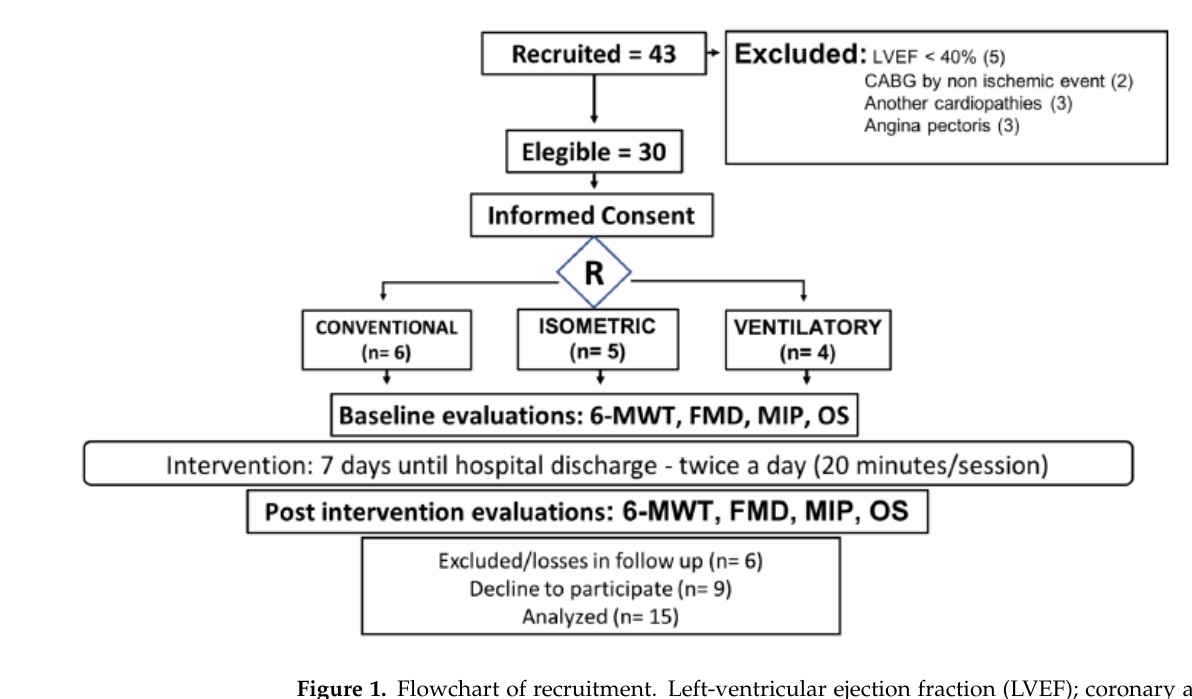
Figure 1. Flowchart of recruitment. Left-ventricular ejection fraction (LVEF); coronary artery bypass grafting (CABG); six-minute walk test (6-MWT); flow-mediated dilatation (FMD); maximal inspiratory pressure (MIP); oxidative stress (OS). Table 1. Demographic characteristics of the participants.